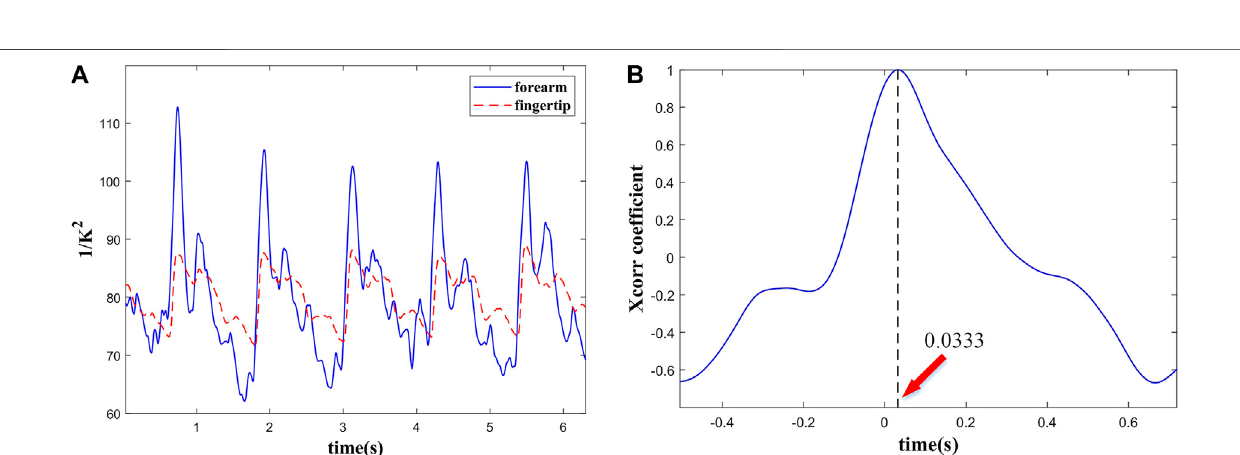
Frontiers in Physics |